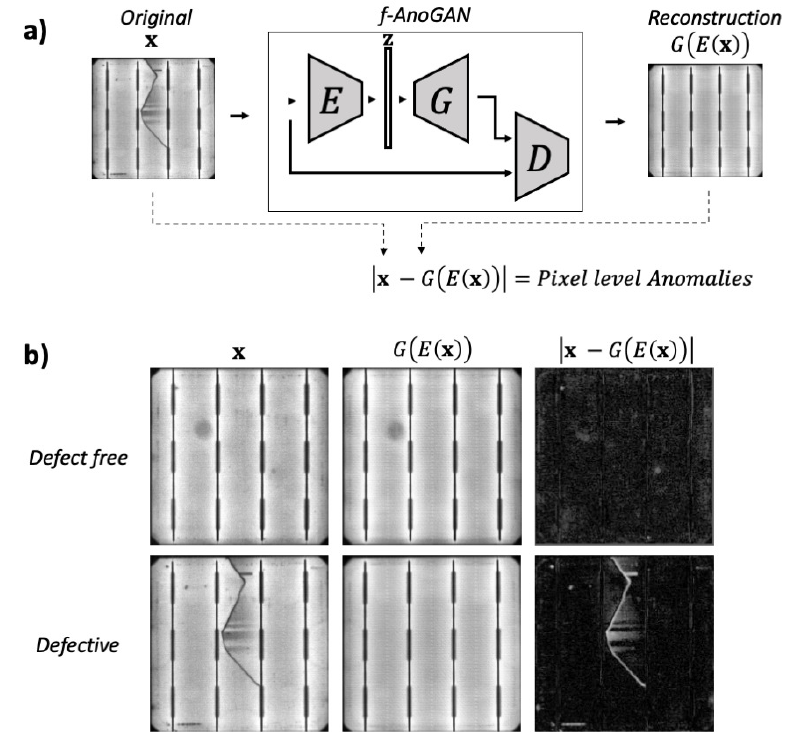
Figure 5. Example anomaly detection with f-AnoGAN. In ( a ) the final structure of the network used for anomaly detection, and in ( b ) some example results obtained when the network process a defect-free cell and a defective cell. This schema was inspired by the images from Schlegl et al. [41]. The absolute value of the pixel-wise difference between the original and the recon- structed image, | x − G ( E ( x )) | , is used for pixel-wise anomaly detection. By applying a threshold c , defined in Equation (4), to the residuals image obtained from | x − G ( E ( x )) | , the binary image y ∈ { 0, 1 } is